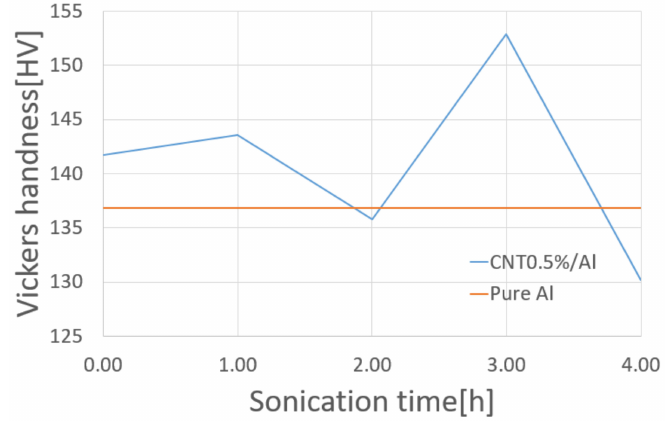
Figure 12. Relationship between Vickers hardness and sonication